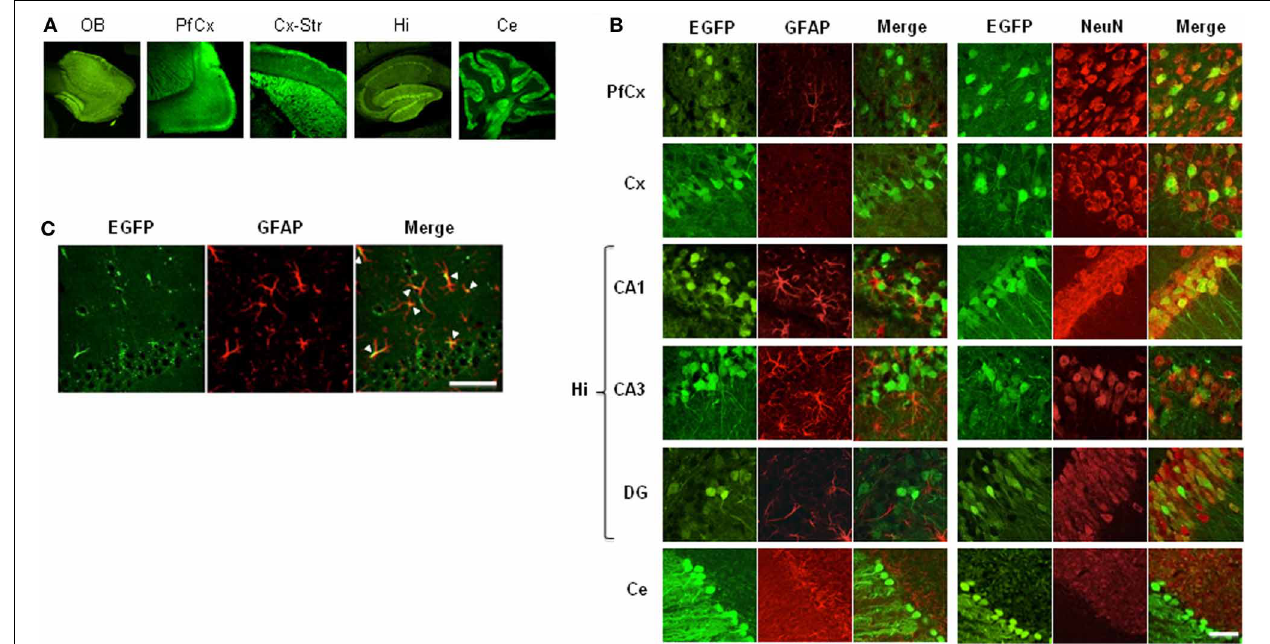
FIGURE 3 | EGFP expression in mice carrying pSico-shRNA3. (A) Immunostaining showing EGFP expression (green) in olfactory bulb (OB), prefrontal cortex (PfCx), cortex and striatum (Cx-Str), hippocampus (Hi), and cerebellum (Ce). (B) EGFP co-immunostaining with the astroglial marker